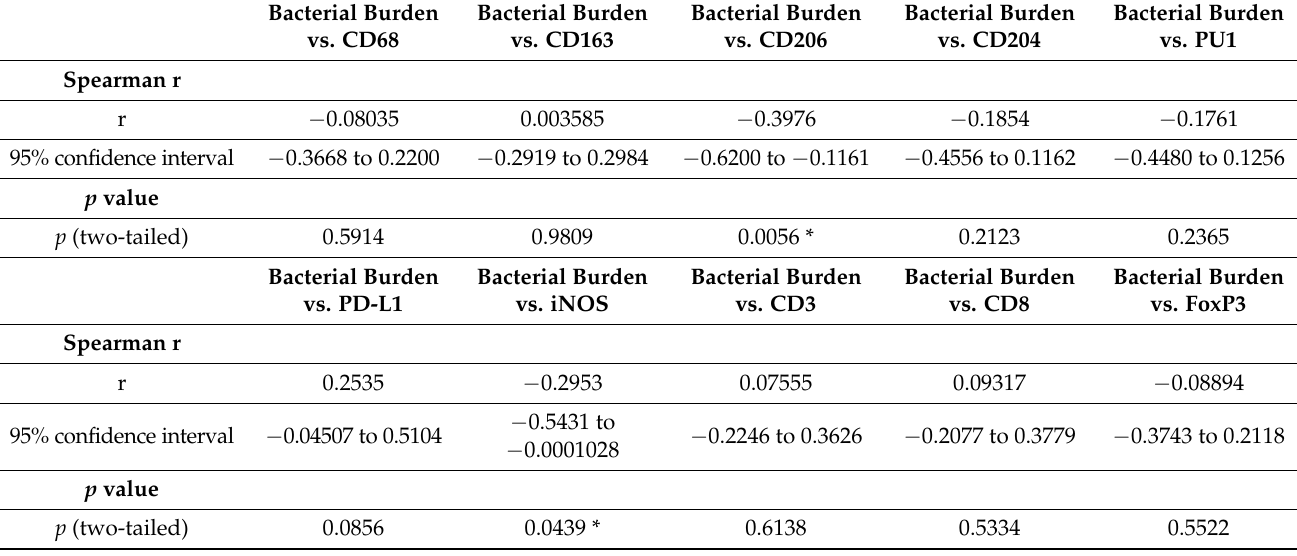
Table 5. Correlation analysis of the total bacterial burden with the phenotype of the tumor stroma.